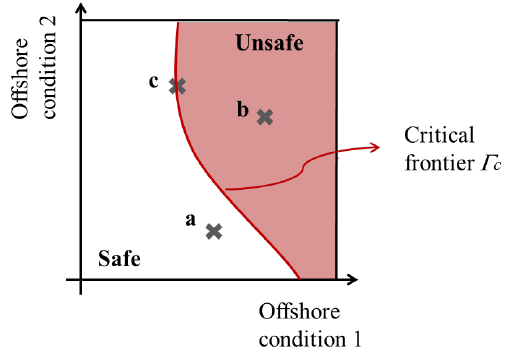
Fig. 1. Schematic representation of the critical frontier 0 c in the Figure 1. Schematic representation of the critical frontier  c in the offshore conditions 4 offshore conditions domain. This frontier represents the boundary domain. This frontier represents the boundary between the ―safe‖ and ―unsafe‖ regions (red-5 between the “safe” and “unsafe” regions (red-coloured area), i.e. coloured area), i.e. the boundary of the set of offshore forcing conditions, which lead to a 6 the boundary of the set of offshore forcing conditions, which lead ―high level‖ of water level at the coast. 7 to a “high level” of water level at the